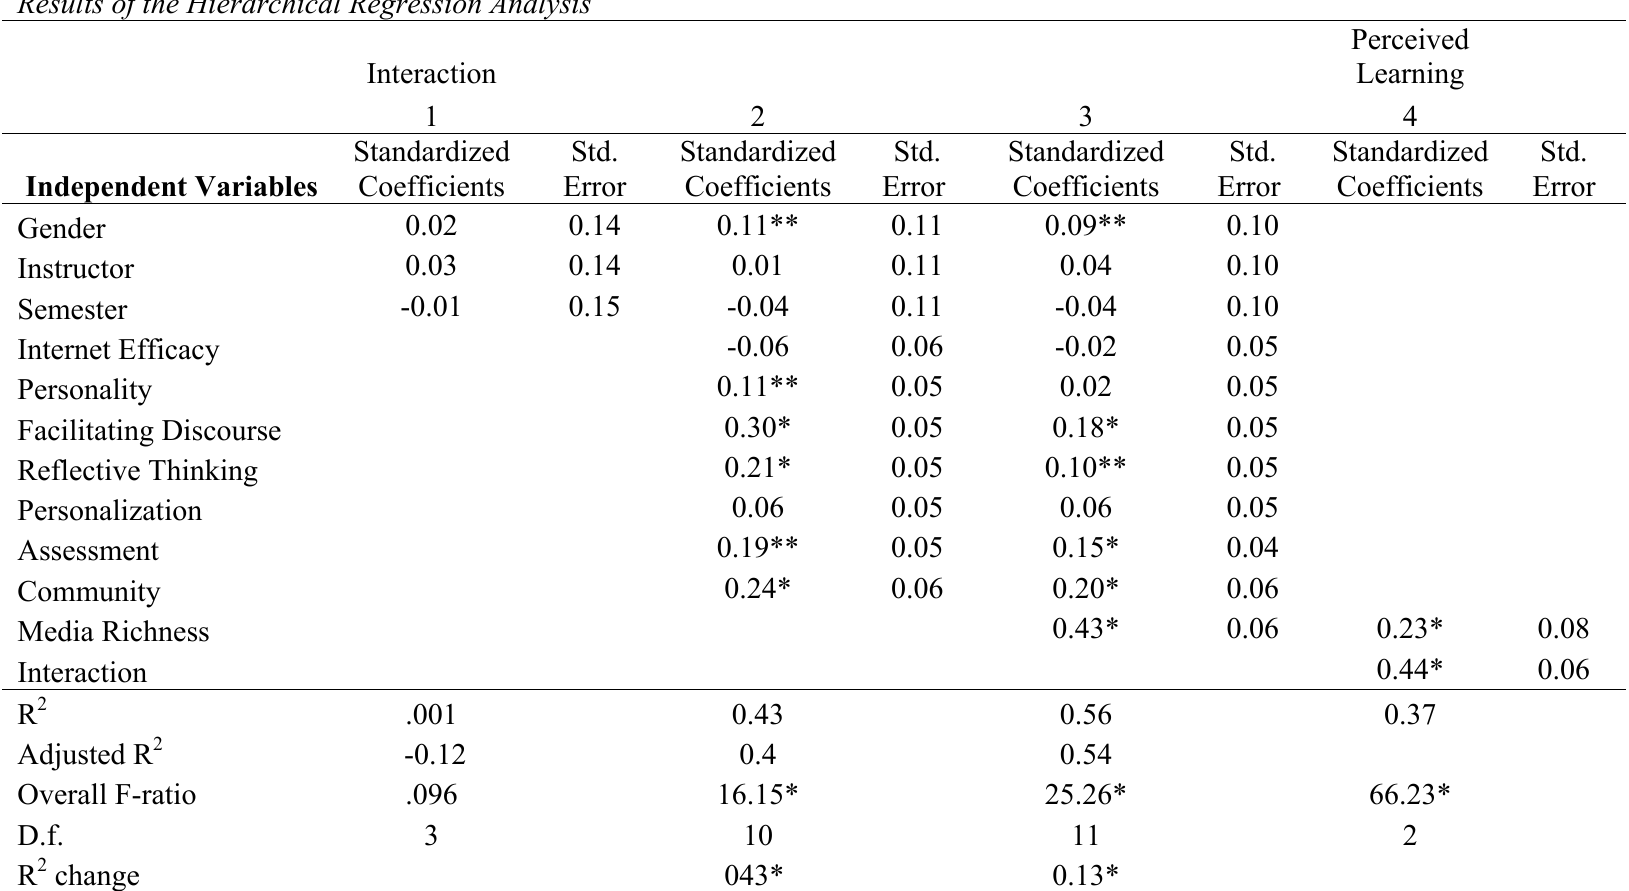
Table 3 Results of the Hierarchical Regression